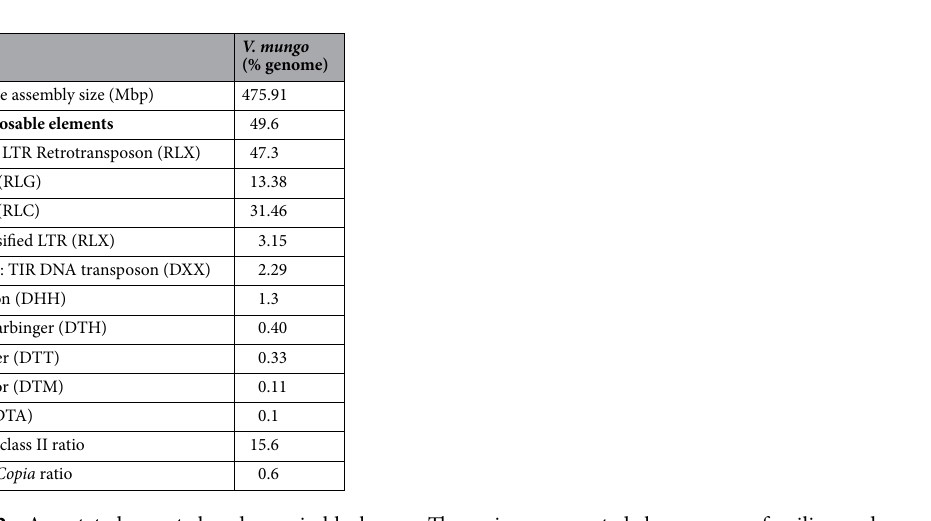
Table 2. Annotated repeat abundances in blackgram. The major represented classes, super-families, and subgroups of transposable elements as determined by automated annotation and classified according to the scheme of Wicker et al. 27 , as well as other major repeat types are